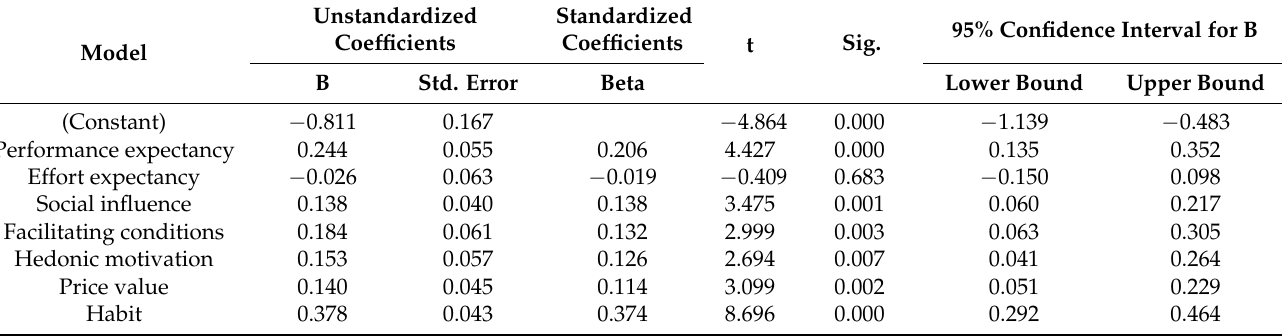
Table 9. Linear regression